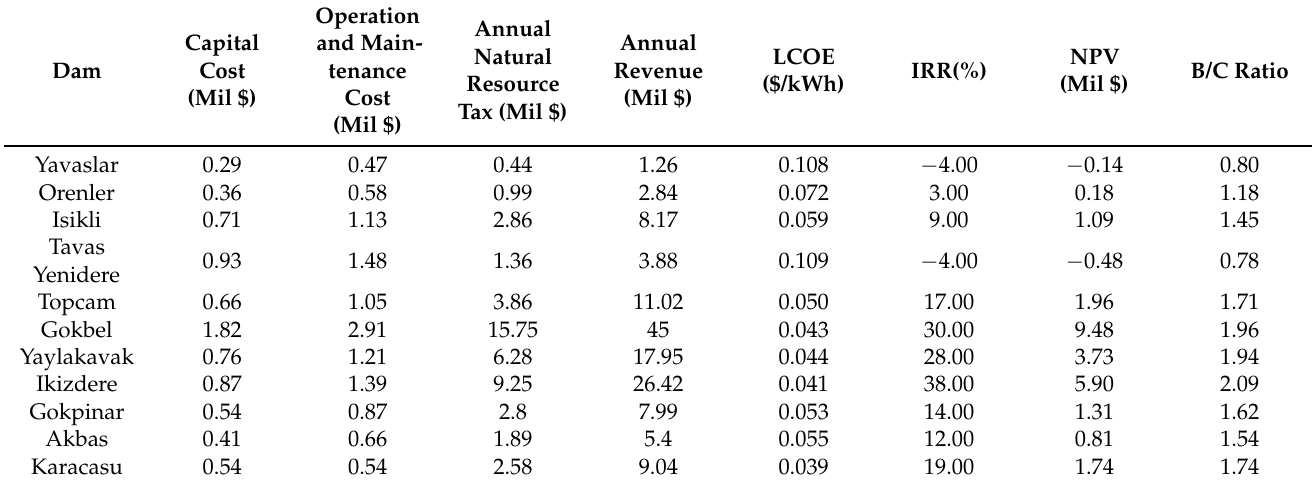
Table 5. Economic key numbers and indicators for the retrofitting of the